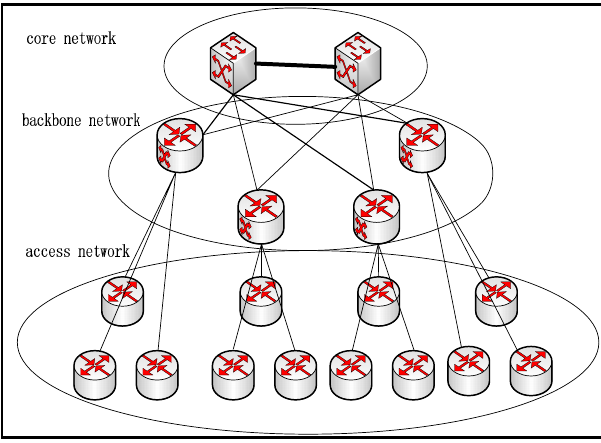
Figure 1. Power communication network architecture.